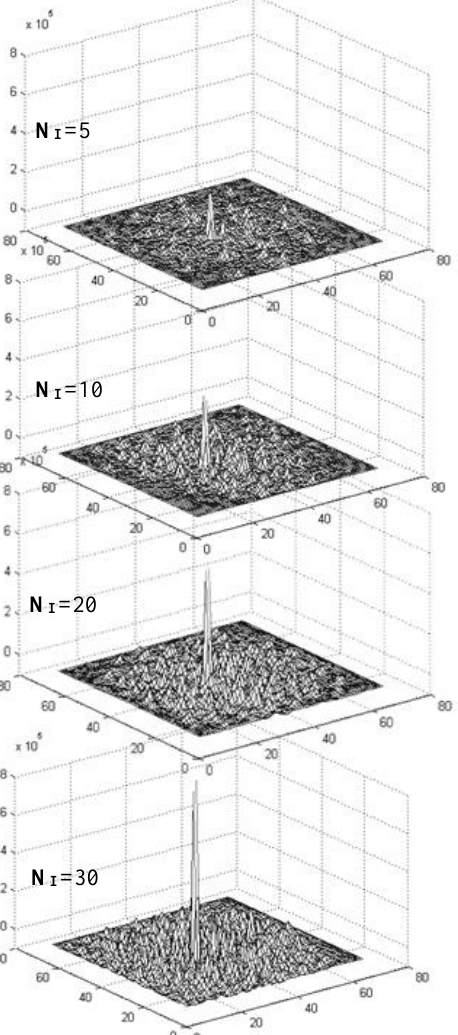
Fig. 2. Correlation between velocity gradient and signal peak